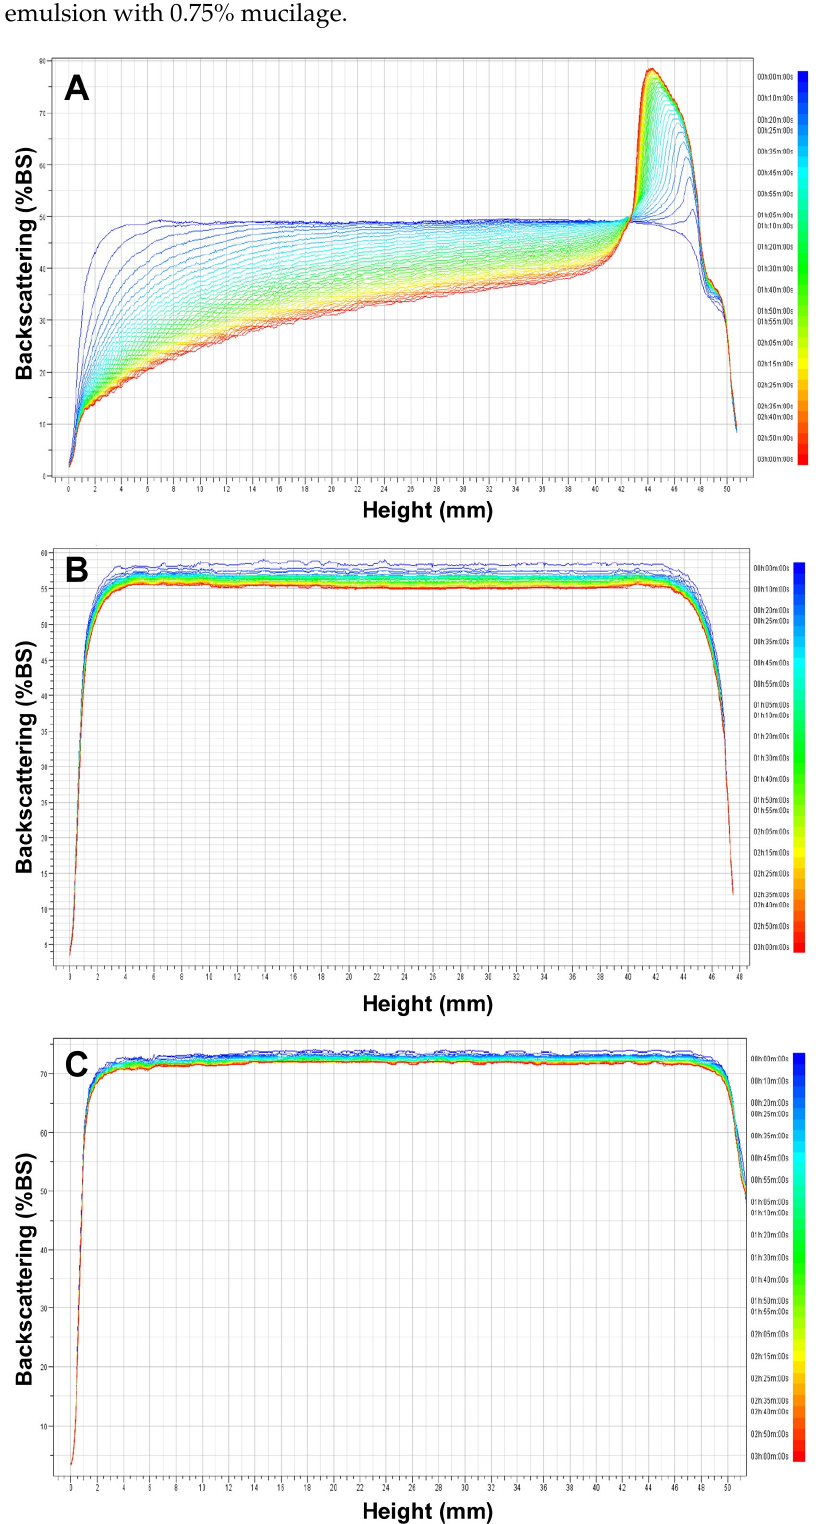
Figure 5. Backscattering profiles versus sample height (mm) of O/W emulsions with the addition of C. olitorius mucilage: ( A ) 0%, ( B ) 0.75%, and ( C ) 1.00%. The different colored lines represent the scanning curve in different times.